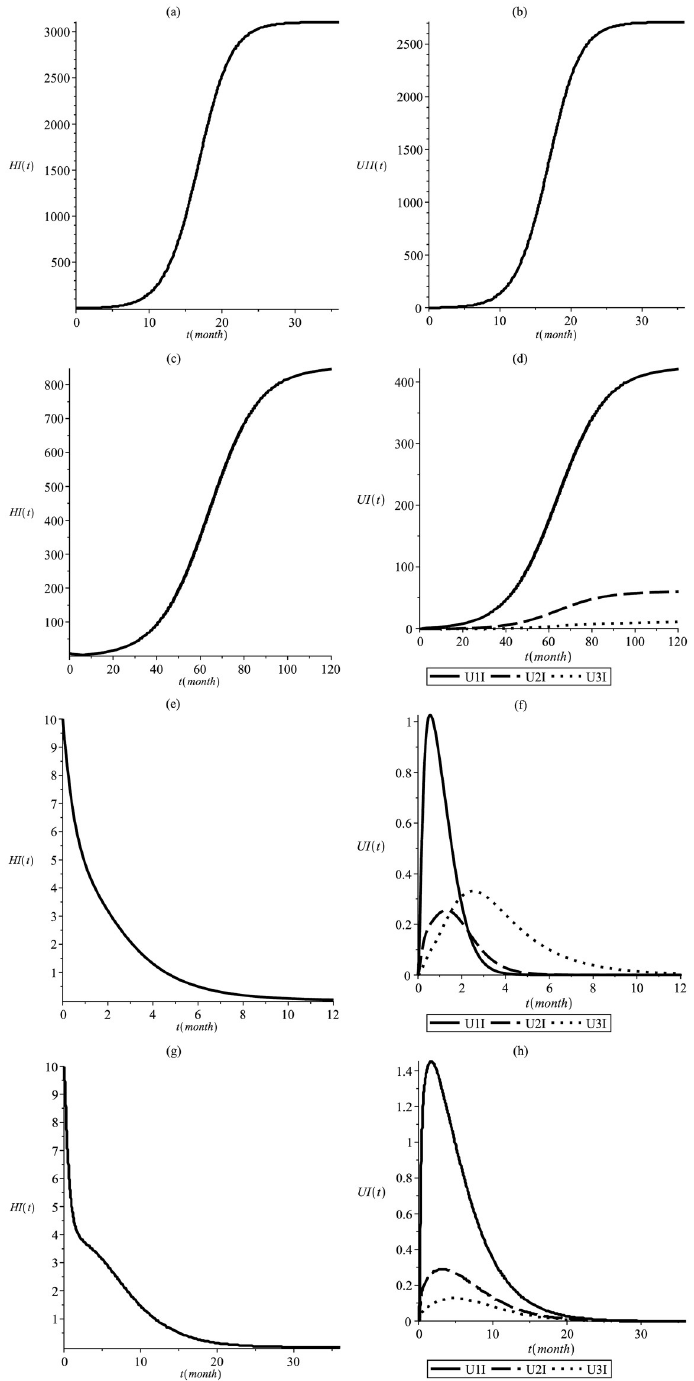
Fig 8. This simulation shows the infectious dynamics at T = 32˚C and p 1 = 0.6, p 2 = 0.3, p 3 = 0.1. Infectious human (a) and wild mosquitoes (b) in the absense of transgenic, resulting in R 0 = 1.8; infectious human (c) and mosquitoes (d) considering Mendelian inheritance and resulting in R Mend = 1.14; infectious human (e) and mosquitoes (f) considering MCR inheritance and without fitness cost resulting in R = 0.36; infectious human (g) and mosquitoes (h) MCR considering MCR inheritance and fitness cost resulting in R MCR =